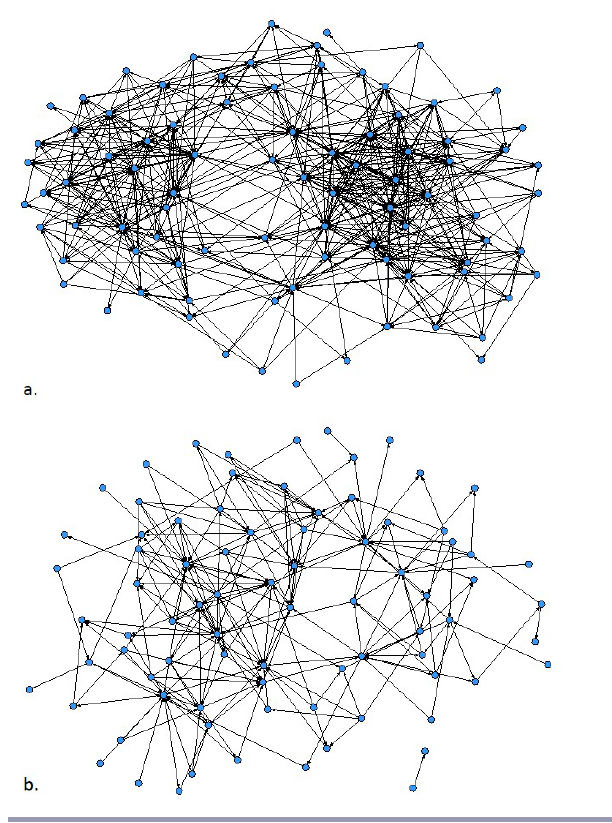
Fig. 2 . Graphic representations of the 87 organizations concerned with increasing wildfire risk in the study area and the ties the organization representatives reported with the organizations that (a) they work with and (b) from which they seek information and